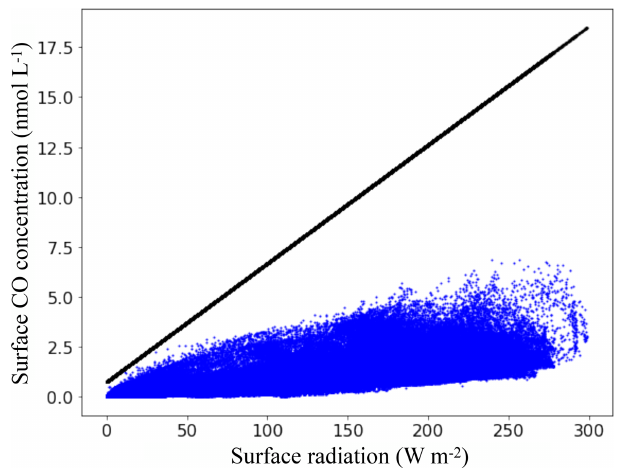
Figure 10. Surface CO concentrations as a function of the total solar radiation available at the surface ocean. Blue dots are mean annual surface concentrations retrieved from PISCES and the black line is the linear relation used by Erickson